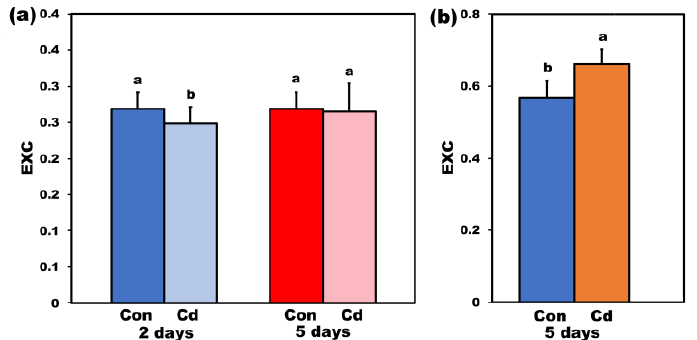
Figure 6. Changes in the excess excitation energy (EXC) measured at 220 μmol photons m −2 s –1 of control (con) and2- and 5-days Cd-treated Salvia sclarea plants ( a ) and the EXC measured at 900 μmol photons m −2 s –1 of control (con) and 5 days Cd-treated S. sclarea plants ( b ). Error bars are standard deviations (n = 6). Columns with different letters are statistically different ( p < 0.05).